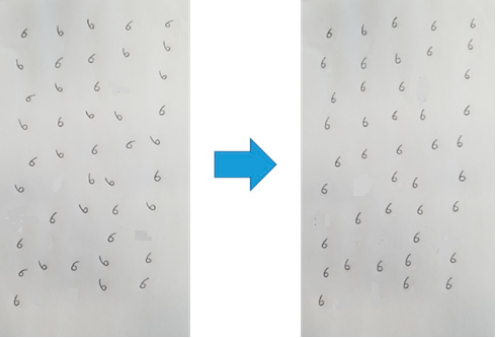
Figure 19. Tilt correction examples of “6” following the proposal ( left : original, right : tilt correction results).